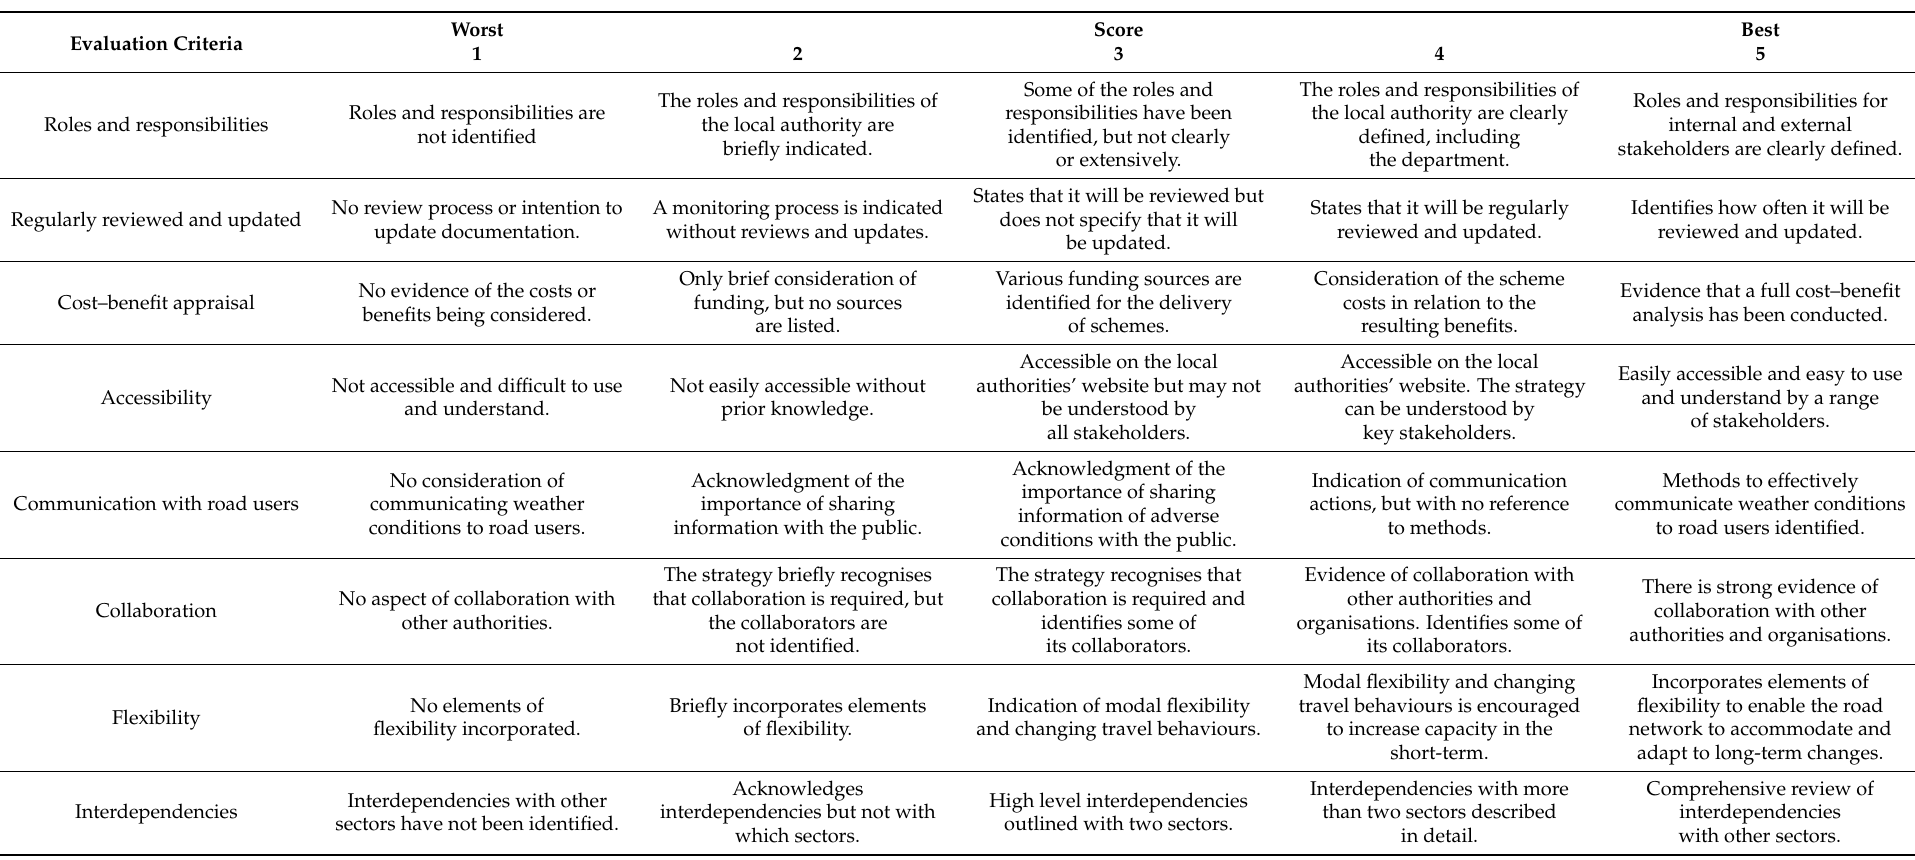
Table 3. Scoring criteria to evaluate regional policy